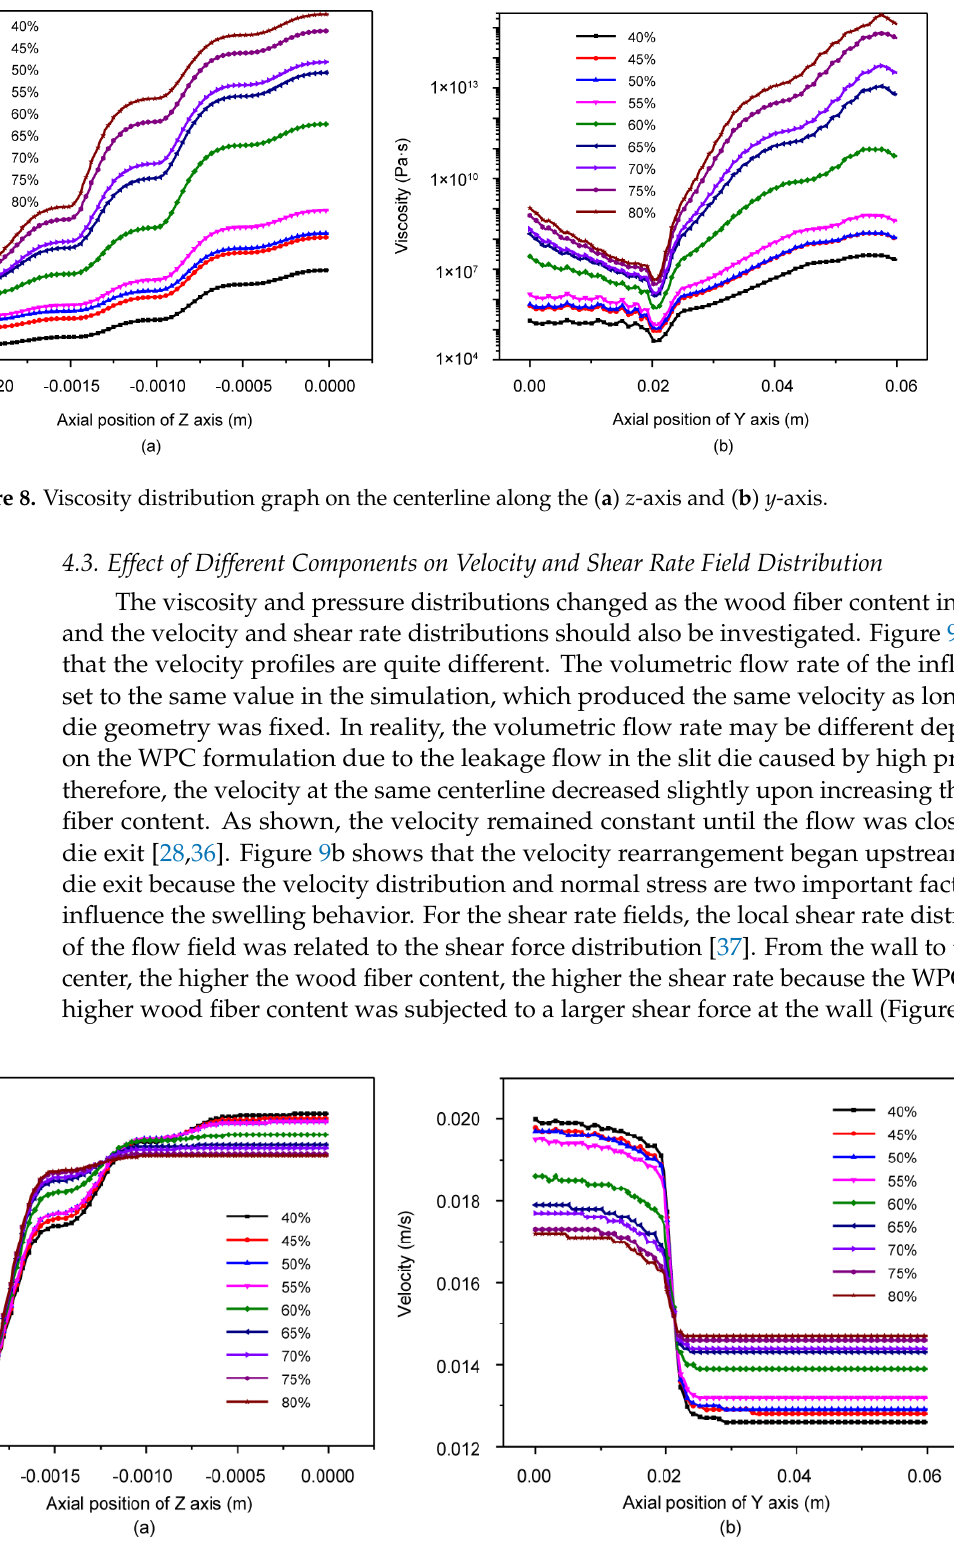
Figure 9. Velocity distribution on the centerline along the ( a ) z -axis and ( b ) y -axis.